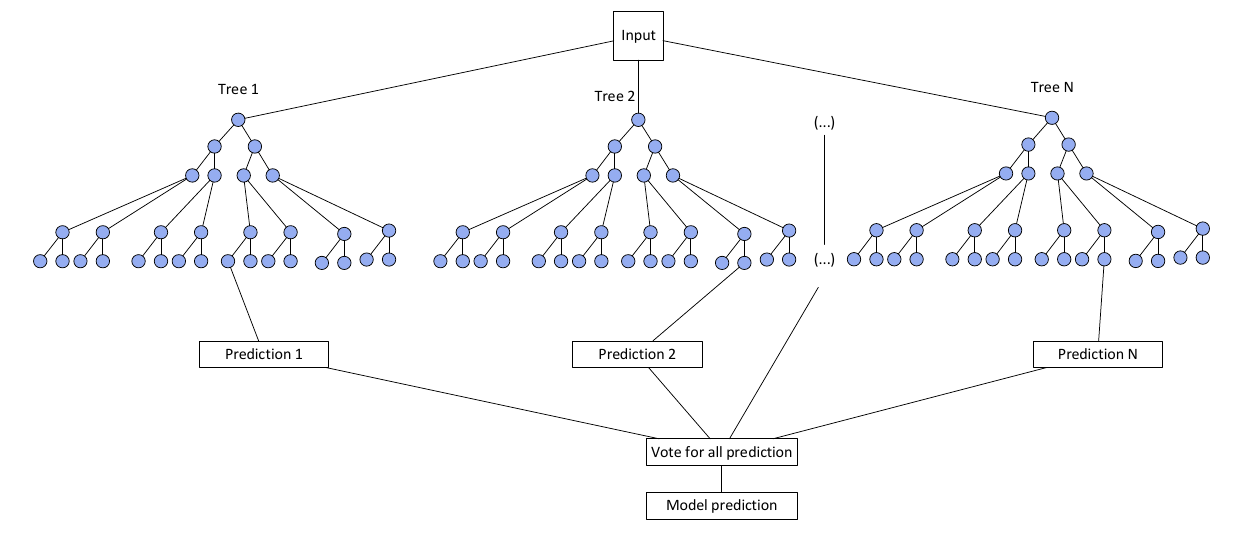
Figure 5. The architecture of random forest.